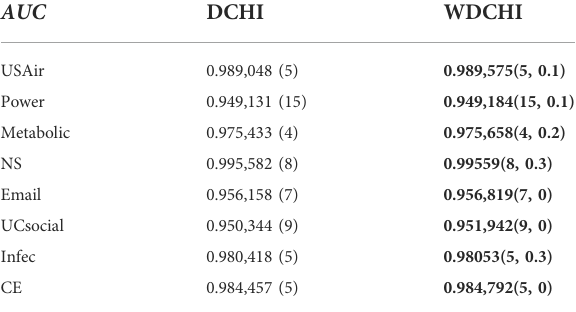
TABLE 2 AUC on the twelve benchmark networks with L = 100 as the line rate. Each data point represents the average of more than 30 independent realization methods, with each point being a random 90% – 10% division of the training set and testing set.